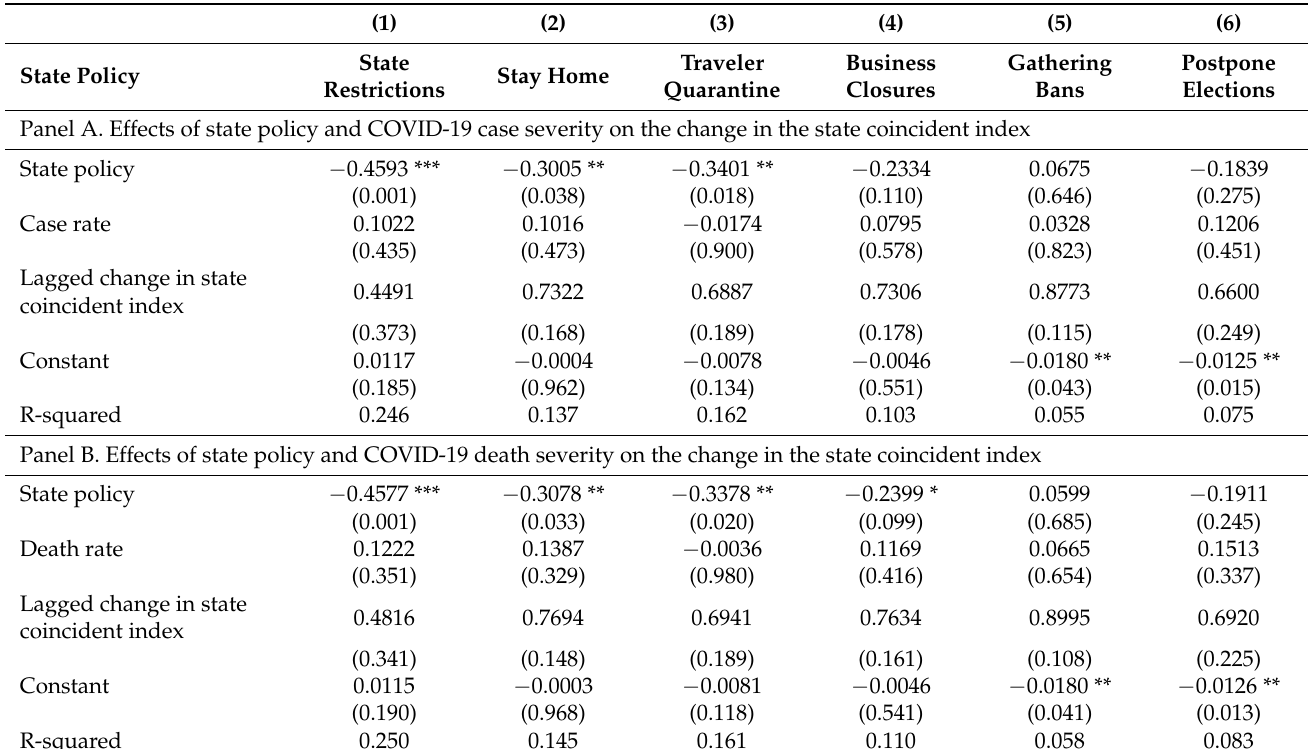
Table 7. Effects of state policies and COVID-19 severity on local economic